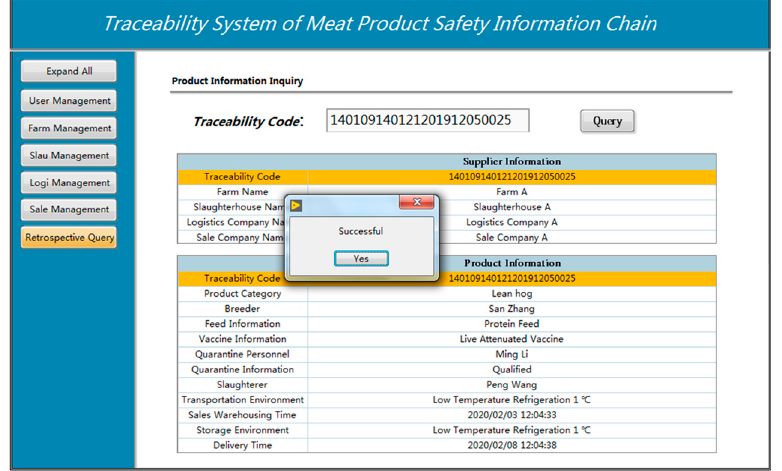
Figure 18. Traceability platform testing.